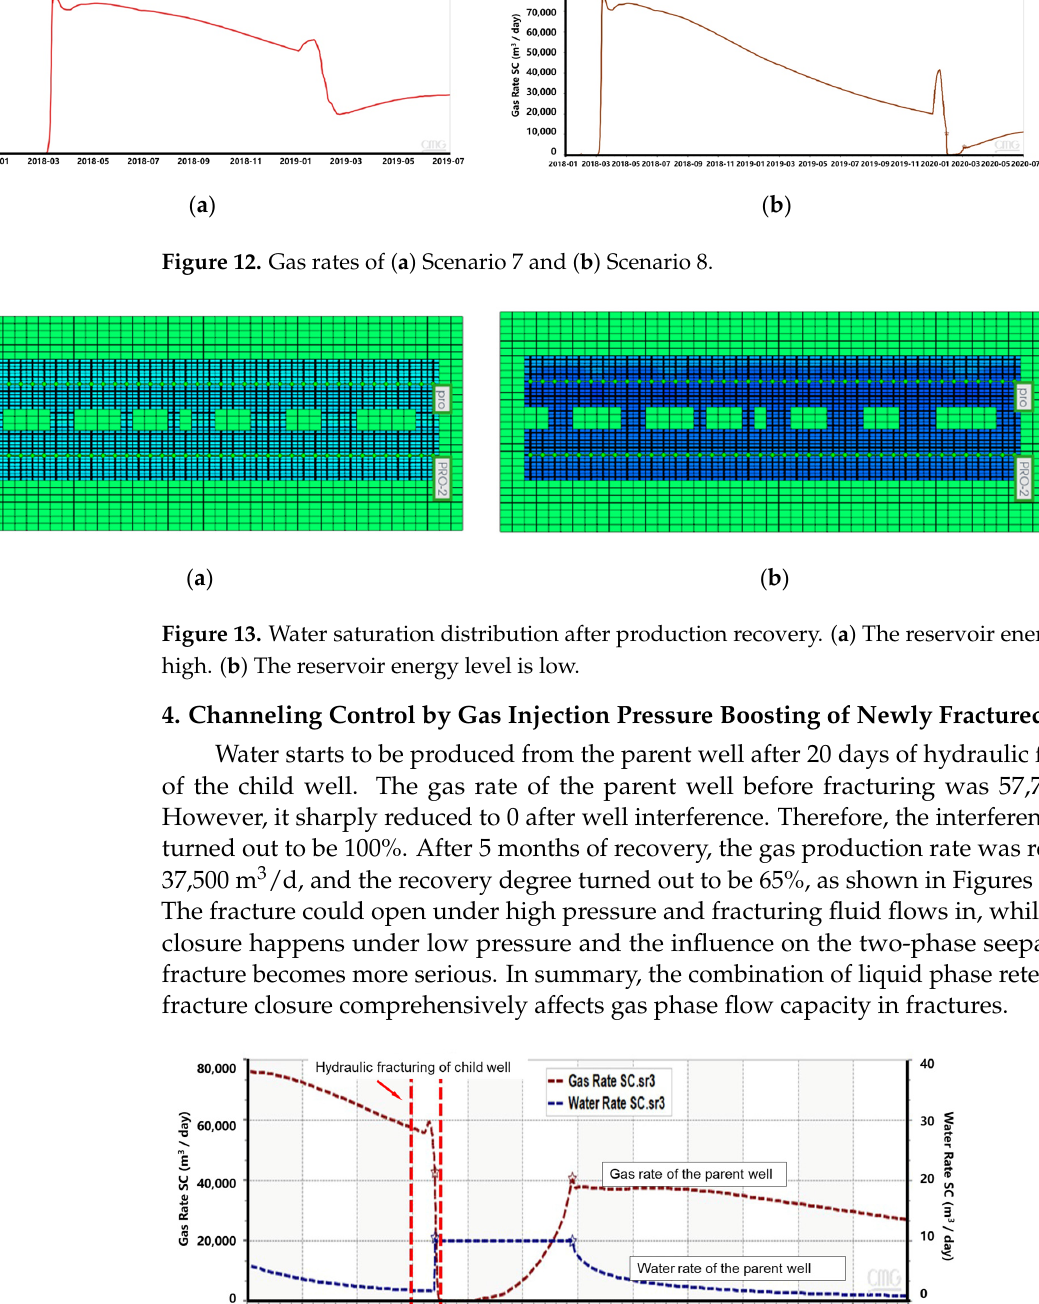
( b ) Figure 10. 3 D grid mesh division of numerical models of Scenarios 5 and 6. ( a ) Well spacing is 300 m. ( b ) Well spacing is 510 m . ( a ) ( b ) Figure 11. Comparison of gas rate and water rates of different scenarios. ( a ) Gas rate. ( b ) Water rate. 3.5. Effect of Hydraulic Fracturing Timing on Production The effect of fracturing timing on production is analyzed in Scenarios 7 and 8. In Scenario 7, after one year’s depletion of the parent well, the child well starts hydraulic